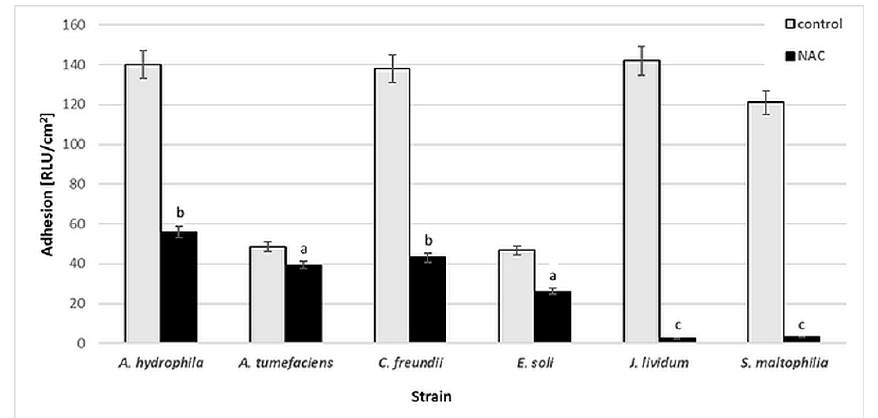
Figure 2. Adhesion [RLU/cm 2 ] of bacterial strains to glass surface after 6-day incubation in minimal medium M1 with 0.25% ( w / v ) NAC in comparison to that of control samples (without NAC). Values show the mean ± standard deviation (SD, n = 3). Values with different letters are statistically different: a, p ≥ 0.05; b, 0.005 < p < 0.05; c, p < 0.005.